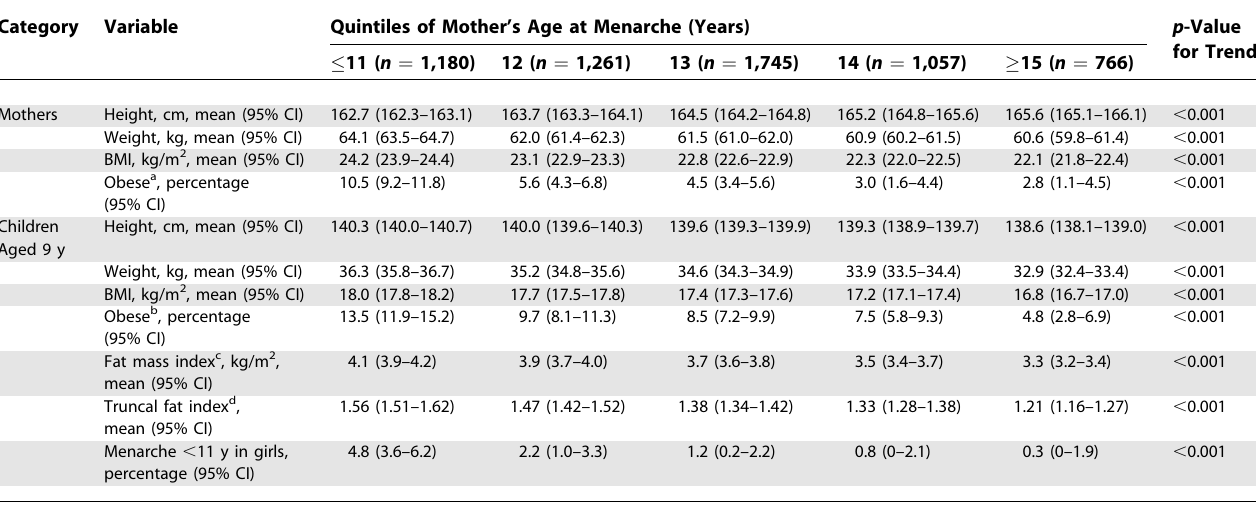
Table 1. Body Size and Obesity Risk of Mothers and Children at 9y by Quintiles of Mother’s Age at Menarche Category